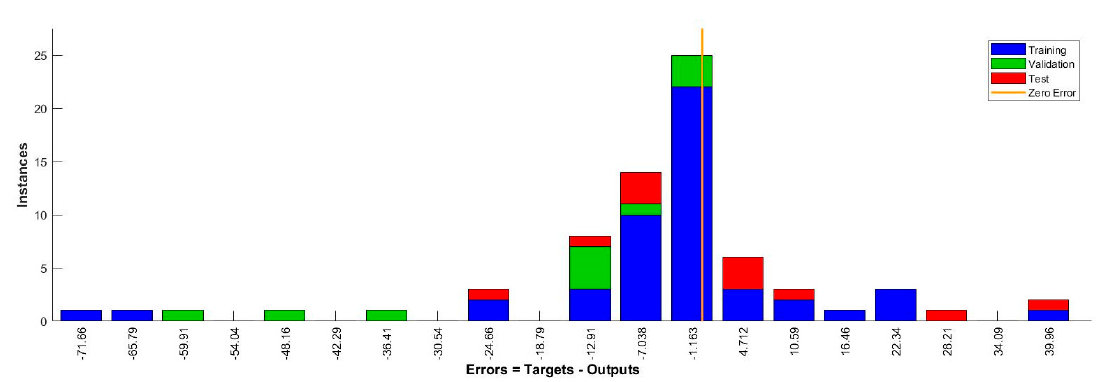
Figure 5. Error distribution during the development and testing of the ANN model for CH 4 emissions.